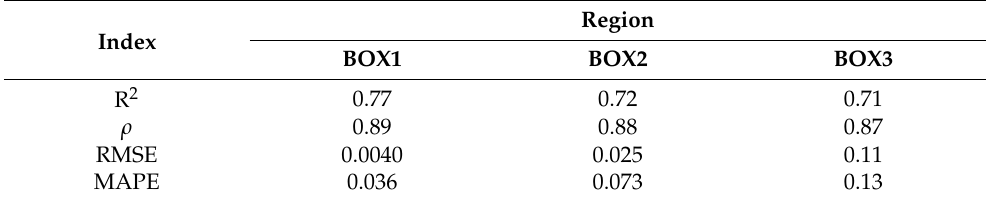
Table 3. Statistical results of the comparison between the observed Chl a values and the predicted Chl a concentration by the IDNN models using BGC-Argo data. R 2 refers to the Determination Coefficient, ρ to the Pearson’s correlation coefficient, RMSE denotes the root mean square error, and MAPE represent the mean absolute percentage error.